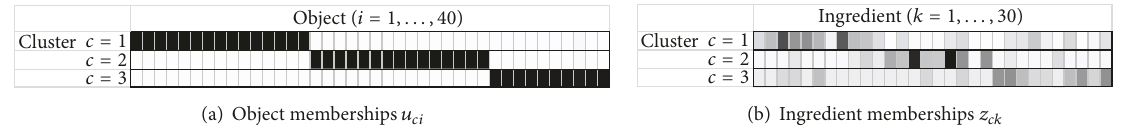
Figure 5: Derived memberships by conventional FCCM.